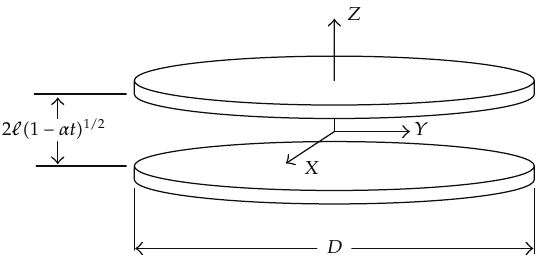
Figure 1: Schematic diagram of the